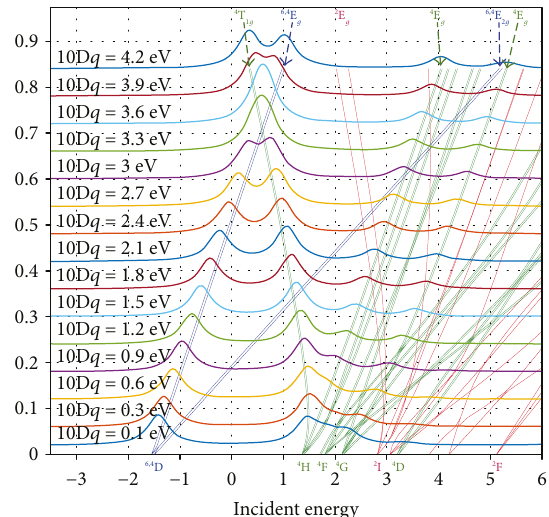
Figure 28: 1s XAS projections of a calculated 1s2p RIXS spectrum for Cr 3+ (3d 3 ) with